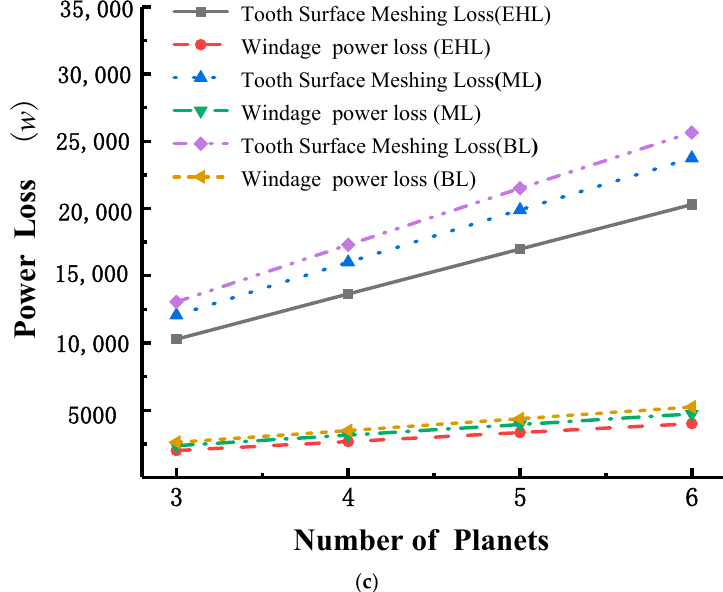
Figure 14. Power losses of herringbone planetary gear transmission system under different lubrication conditions. ( a ) Power loss due to tooth friction; ( b ) windage power loss; ( c ) total power loss.